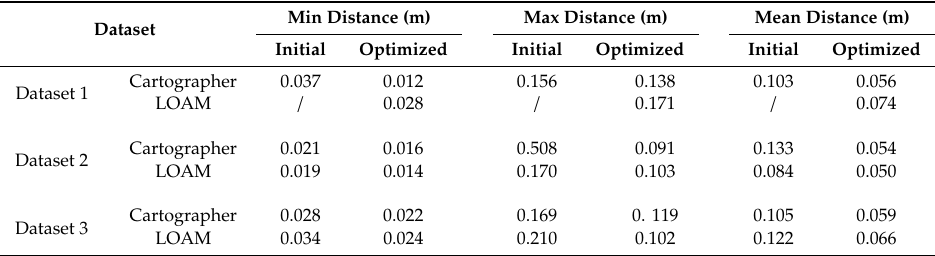
Table 4. The plane-to-plane distance estimation result of datasets. For the raw output point cloud of LOAM is distorted severely in dataset 1, the initial values are